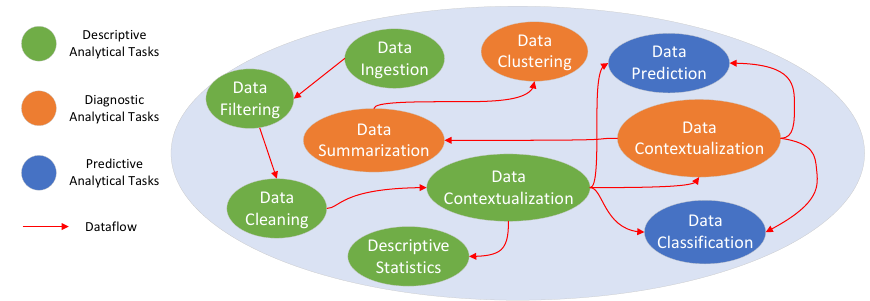
Figure 1. Overview of streaming